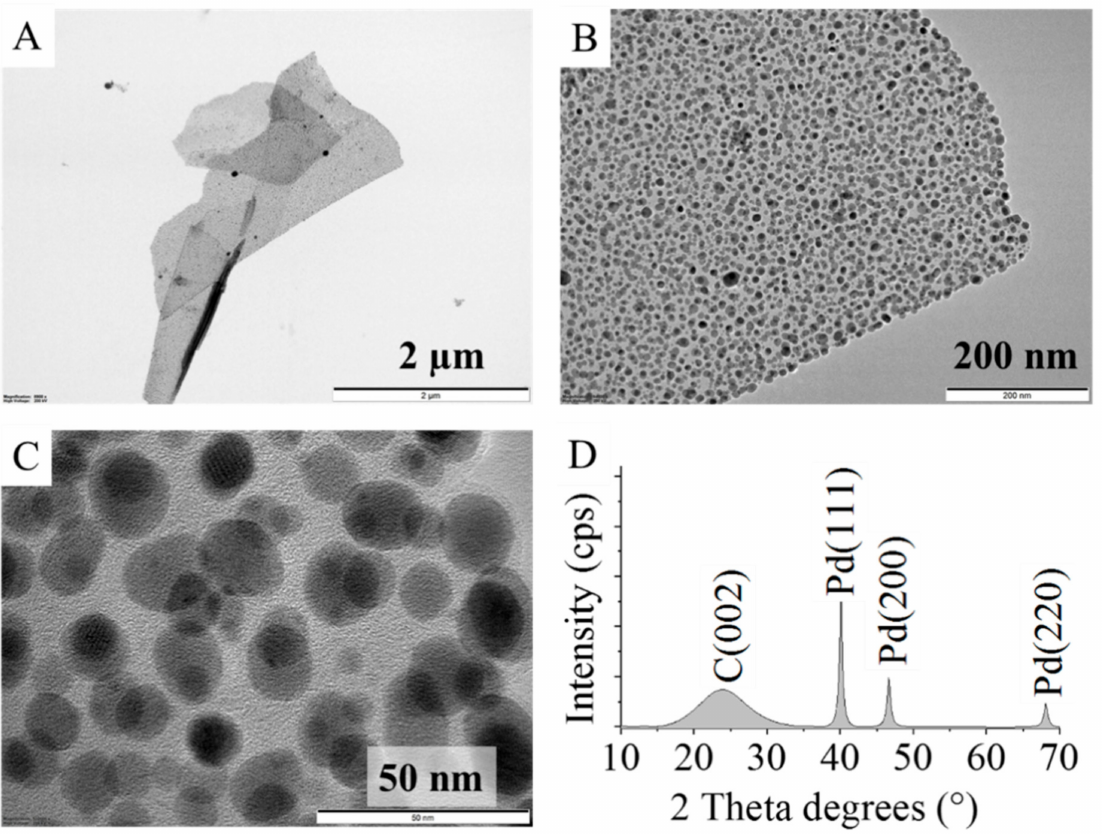
Figure 3. TEM images of the palladium decorated carbon foil ( A , B ) and the Pd nanoparticles on the surface ( C ). XRD pattern of the Pd decorated carbon foil catalyst ( D